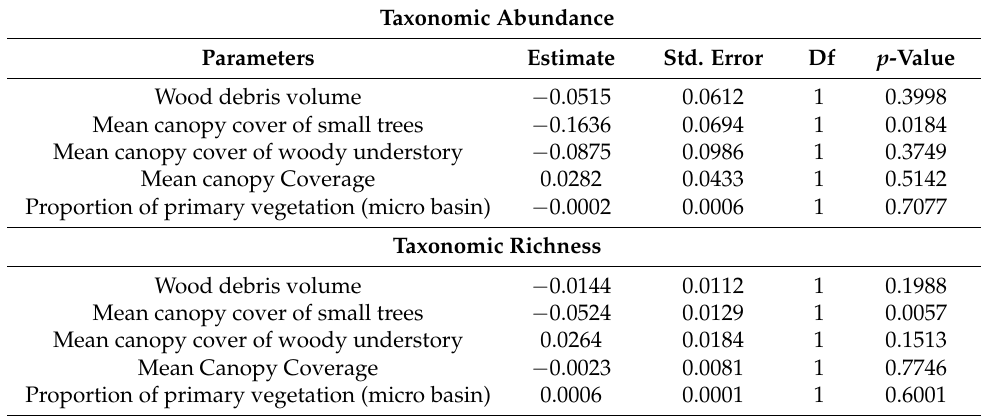
Table 3. Results of General Linear Mixed Model (GLMM), describing the effects of environmental variables on the abundance and taxonomic richness of Odonata in the Brazilian Amazon.